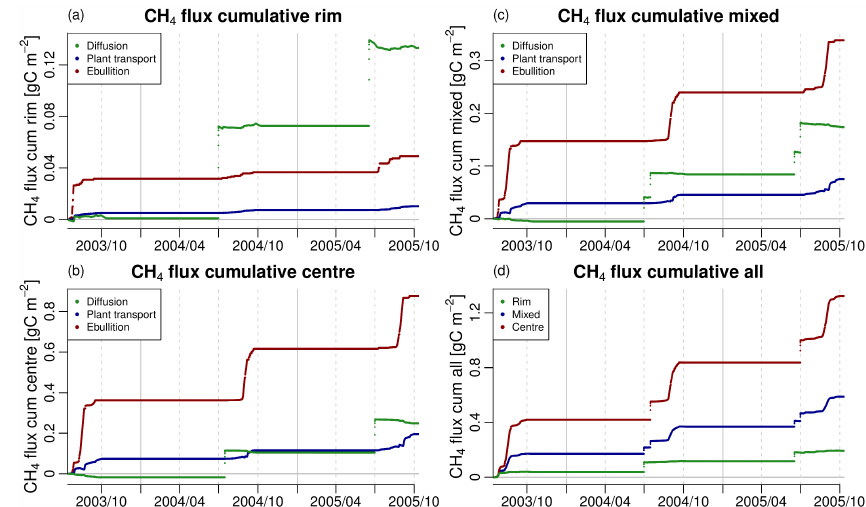
Figure 3. Modelled methane flux out of soil at (a) the rim, (b) the centre, (c) a mixed approach of 65% rim plus 35% centre, split into the different transport processes, and at (d) the rim, the centre and a mixed approach of 65% rim plus 35% centre combined, as a cumulative sum. Solid lines indicate 1 January; dashed lines indicate 1 April, 1 July and 1 October of the respective year. Please note the different scales. Table 1 gives the maximal values.